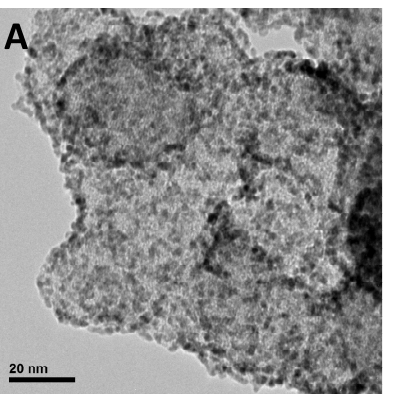
Figure 2. Representative TEM micrographs of the PtRu electrocatalysts ( a ) PtRu/CXG-COL; ( b ) PtRu/CXG-COL-TT200 and ( c )